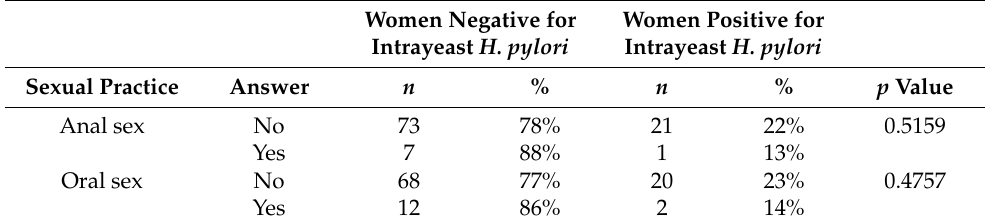
Table 4. Distribution and percentage of term pregnant women positive for yeasts harboring H. pylori cells according to sexual